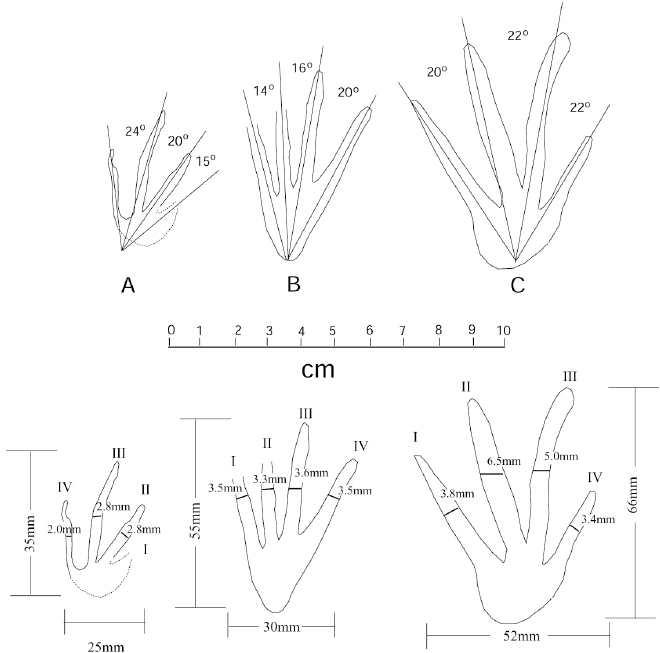
Figure 16. Sketches of Anticusuchipes amnis footprints A – C , showing interdigital angles and track dimensions, specimen WWU-TR-073. Track images have been rotated to show parallel orientations. The original positions are shown in Figure 8.